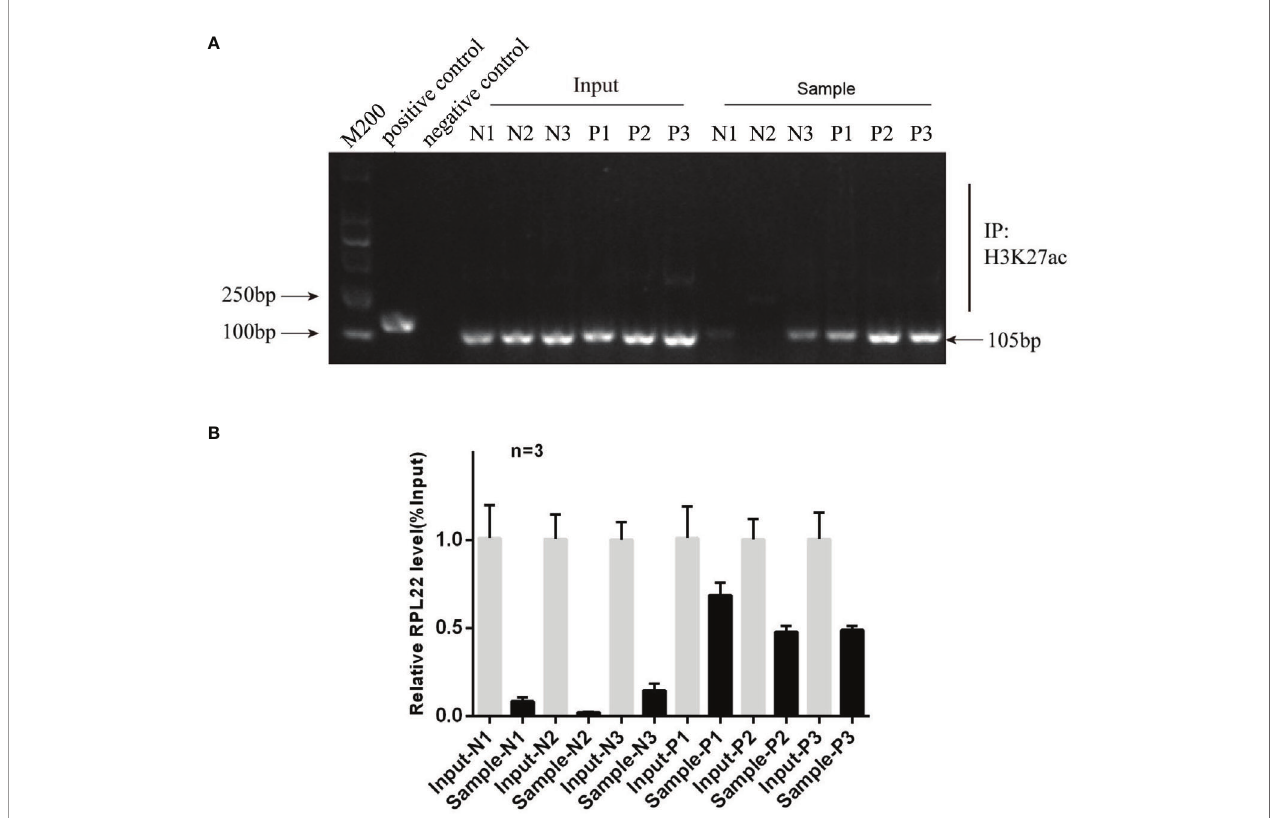
FIGURE 6 | The hyperacetylation level in the promoter region of RPL22 elevates its expression. (A) Electrophoretic image of ChIP assay result showed the histone H3K27 acetylation level on RPL22 promoter in skin lesions derived from PV patients was signi fi cantly higher than healthy controls (n = 3). (B) ChIP-qPCR showed the enrichment of H3K27ac in RPL22 promoter in all three skin lesions derived from PV patients was signi fi cantly higher than healthy